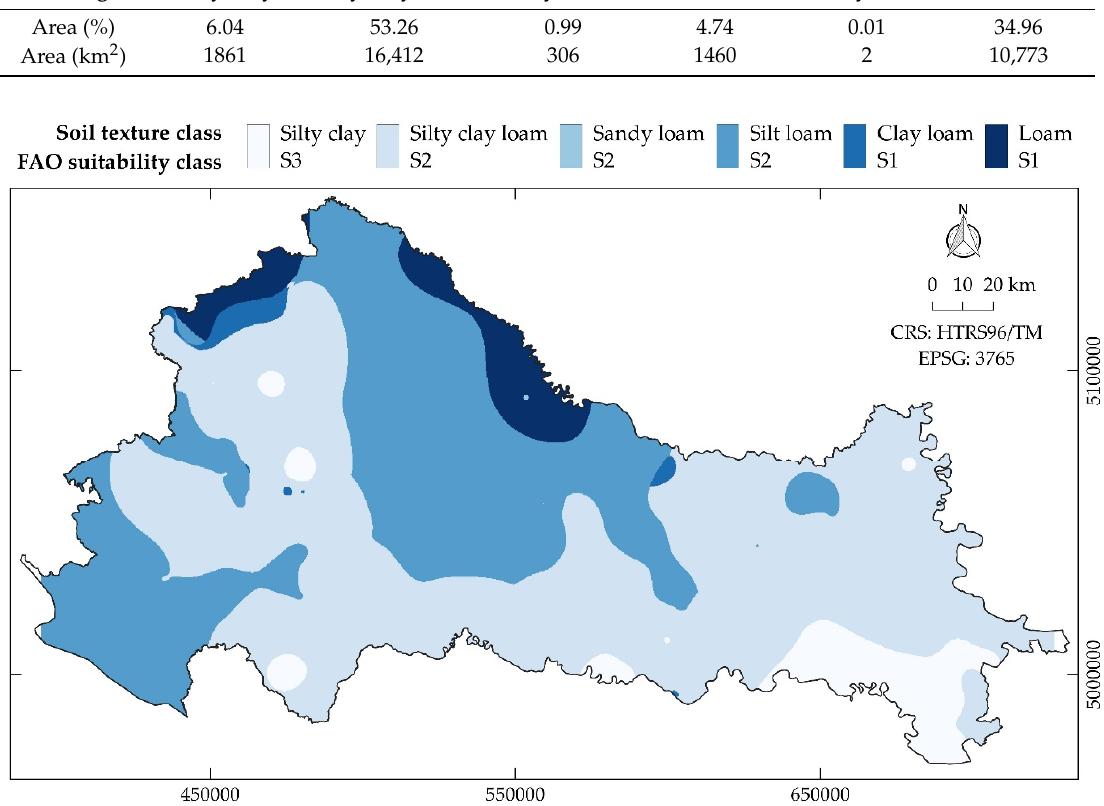
Figure 10. Thematic map of soybean suitability according to soil texture classes.